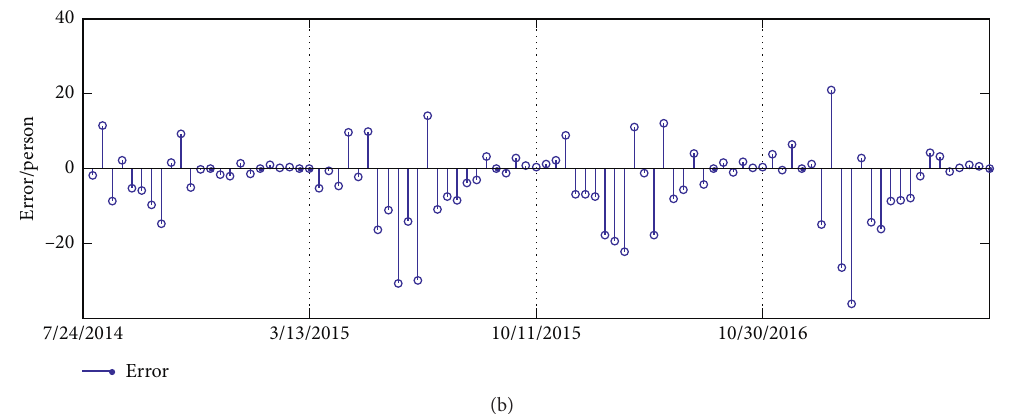
Figure 6: Forecast results of passenger flow caused by activities. (a) Results. (b)